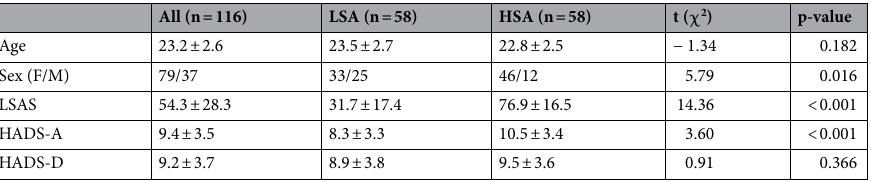
Table 1. Participant demographics and psychometric scale results. LSA low social anxiety group, HAS high social anxiety group, F female, M male, LSAS Liebowitz Social Anxiety Scale, HADS-A anxiety score of the Hospital Anxiety and Depression Scale, HADS-D depression score of the Hospital Anxiety and Depression